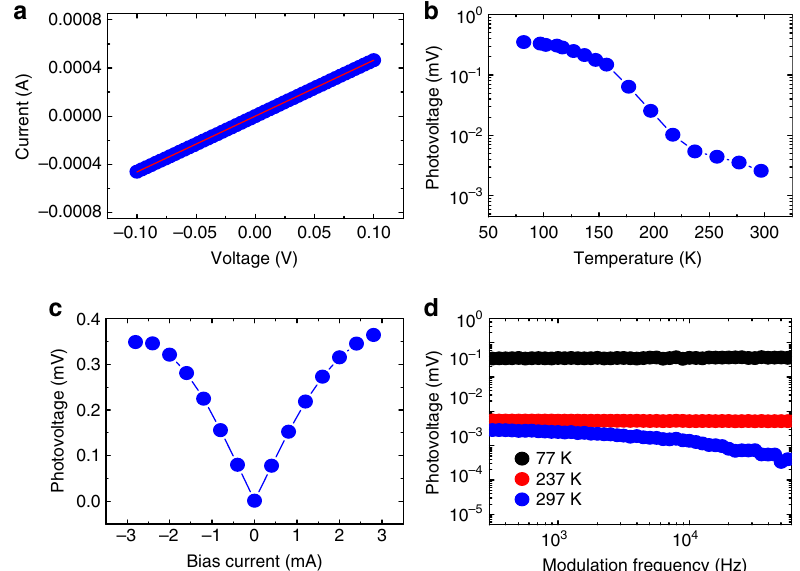
Fig. 5 Temperature effects on the performance of the device with s = 90 µ m. a Current – voltage ( I – V ) curve at 77 K. b Photovoltage as a function of temperature for source power 25 mW and photon energy 0.151 meV. c Photovoltage as a function of bias current at 77 K. d Photovoltage – frequency relations at three temperatures. The black, red, and blue dots correspond to 77, 237, and 297 K,